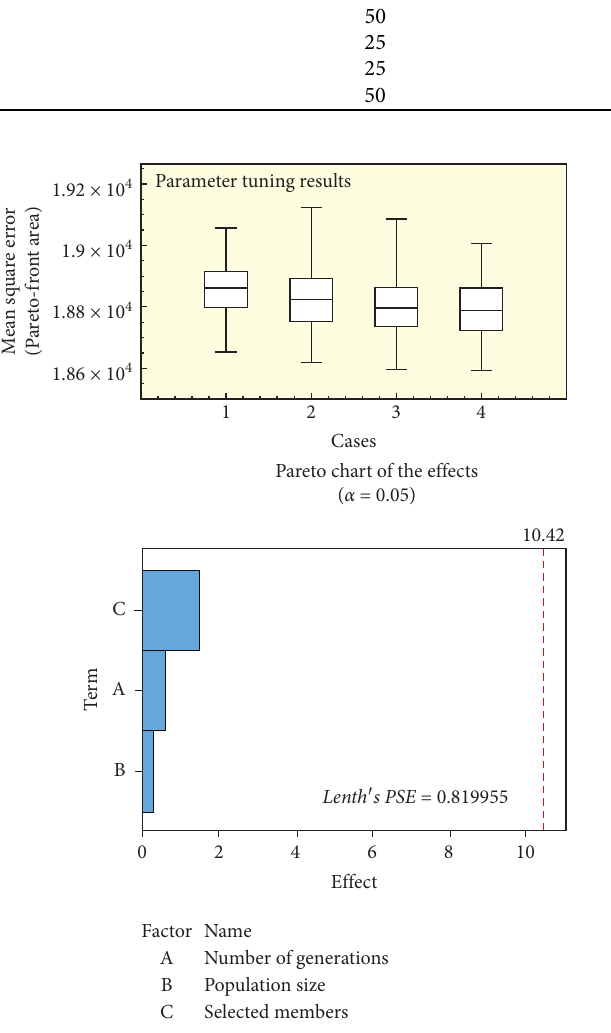
Figure 18. There is no statistically significant difference of any of the three controlled parameters (number of gener- ations, initial population size, and selected population size).